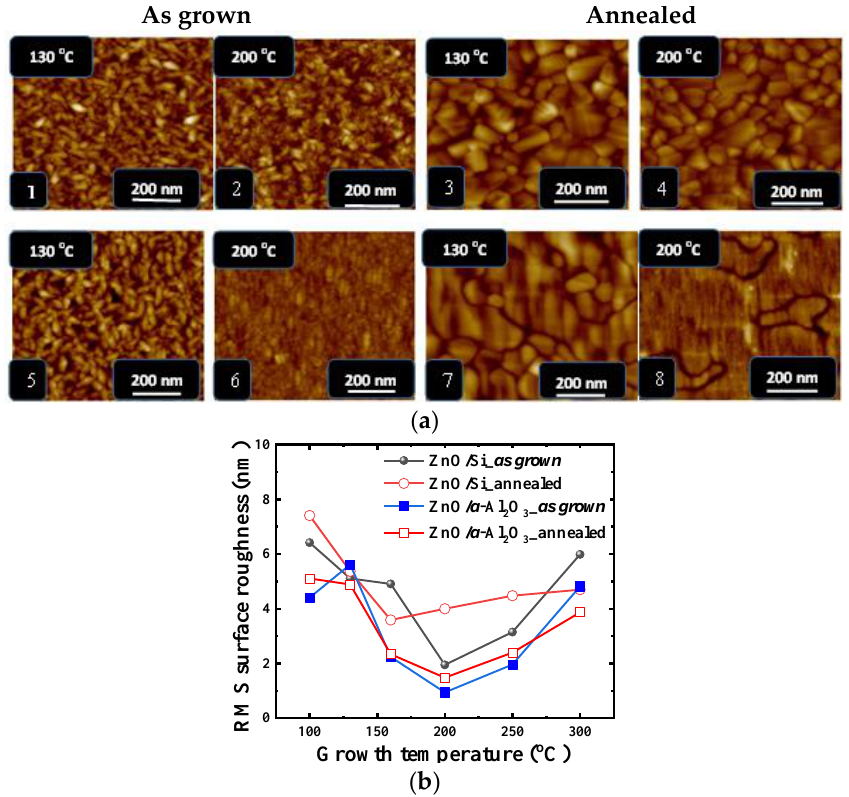
Figure 3. ( a ) Atomic force microscope (AFM) images of as grown (1,2) and annealed (3,4) thin ALD ZnO/Si films and as grown (5,6) and annealed (7,8) ZnO/ a -Al 2 O 3 films grown at 130 ◦ C and 200 ◦ C, respectively; ( b ) the graph of roughness variation with T g for all types of as grown/annealed films is also shown below the